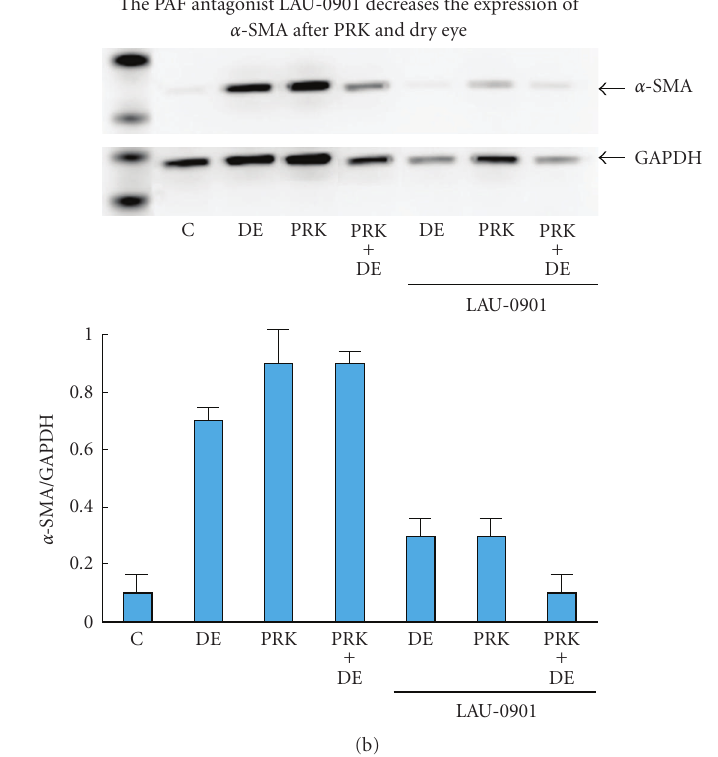
keratocyte cells and the continuing communication between the two are key factors that lead to the successful outcome of the healing response. Manipulating the initial inflammatory cell infiltration with LAU-0901 may a ff ect the corneal wound healing response and may have implications in the predictability and stability of the refractive results after